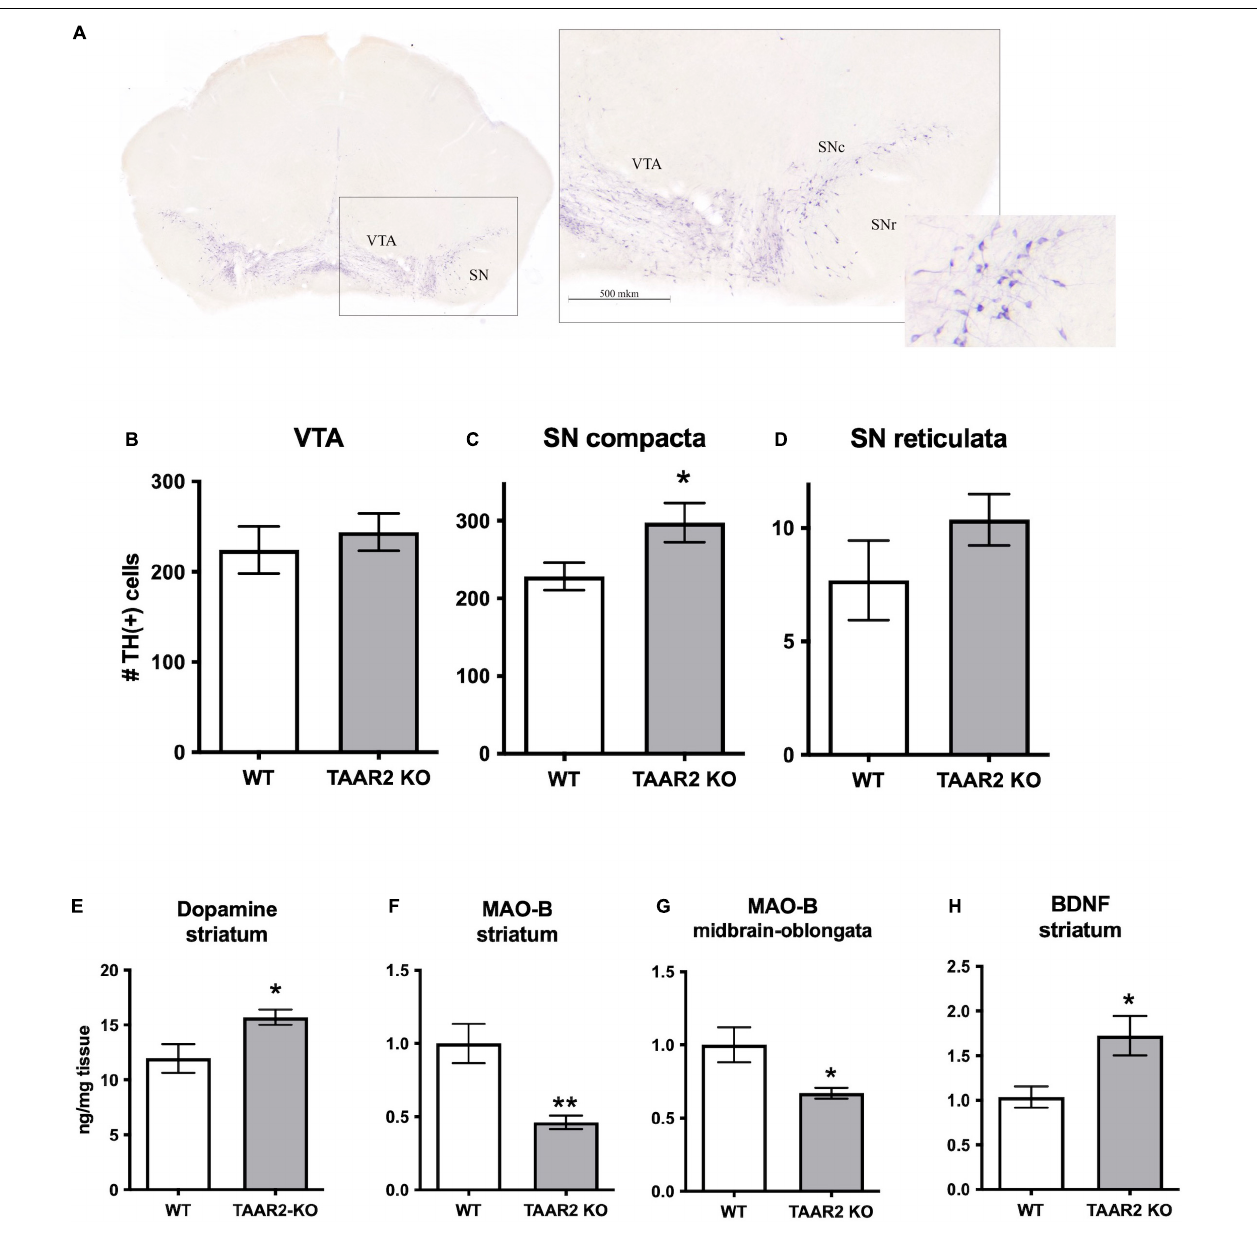
FIGURE 6 | | Changes in the nigrostriatal dopamine system of TAAR2-KO mice. (A) Distribution of the Tyrosine Hydroxylase (TH) immunopositive (TH+) neurons in the ventral tegmental area (VTA) and the substantia nigra (SN) in TAAR2-KO mice. Countered frontal slice of the mesencephalon with TH-labeled neurons (left) and a microscopic view of an enlarged region marked by the black dashed square (right). SNr, SNc—Substantia Nigra pars reticulata, pars compacta. Scale bar—500 µ m. (B–D) The number of TH+ neurons in the VTA (B) , the Substantia Nigra pars compacta (C) , and the Substantia Nigra pars reticulata (D) ; (E) level of dopamine in the striatum tissue ng/mg of tissue; (F,G) Monoamine Oxidase (MAO-B) mRNA level in the striatum and midbrain-oblongata; (H) mRNA level of brain-derived neurotrophic factor (BDNF) in the striatum. All data presented as mean ± SEM. * p < 0.05; ** p < 0.01 t